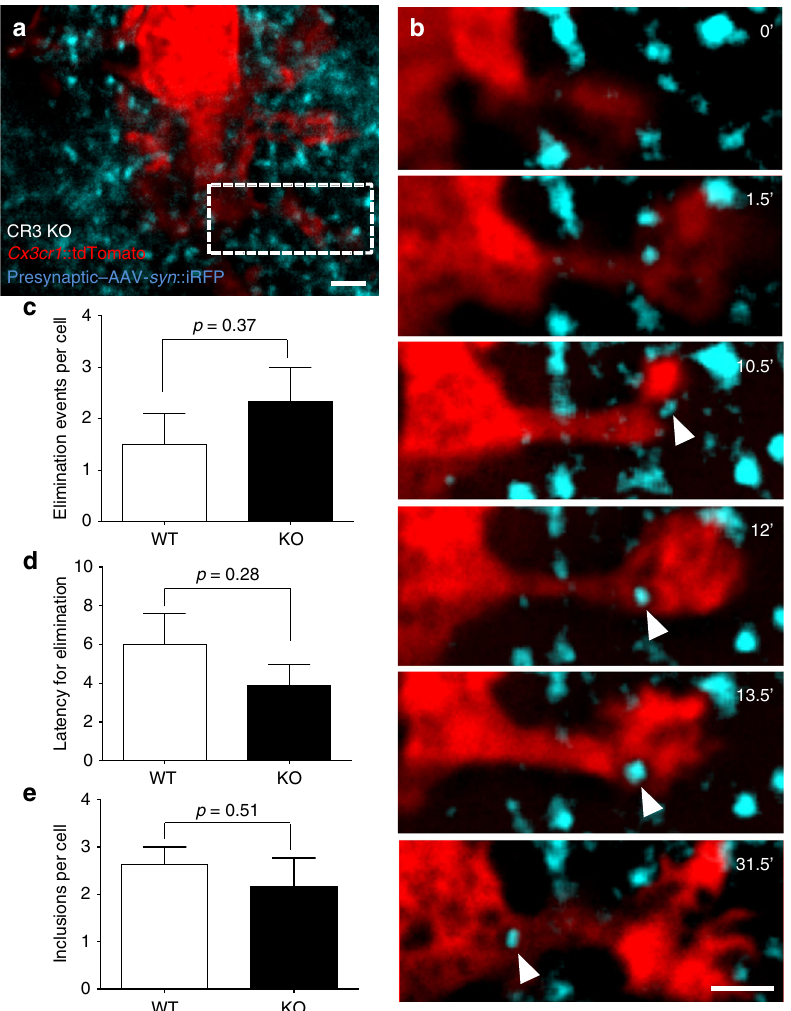
Fig. 5 CR3 is not necessary for microglia trogocytosis. a Low-magni fi cation image of a stack-projection of 33 consecutive optical sections ( Δ z = 0.48 µ m) showing a microglia (red, Cx3cr1 ::CreER; RC ::LSL-tdTomato) surrounded by presynaptic boutons from Schaffer collaterals (blue, AAV- Syn ::iRFP) in organotypic hippocampal slices from CR3 KO mice. b Time-lapse imaging of CR3 KO microglia – bouton interactions revealed engulfment of presynaptic material (single optical planes series from a , dotted box). No difference was found in the c number or d latency of microglia engulfment events, or e the number of iRFP inclusions per cell between WT and CR3 KO slices (two-sided unpaired t -test, n = 8 and 6 cells from 3 organotypic slice cultures, error bars are mean + SEM). Scale bars: 2 µ